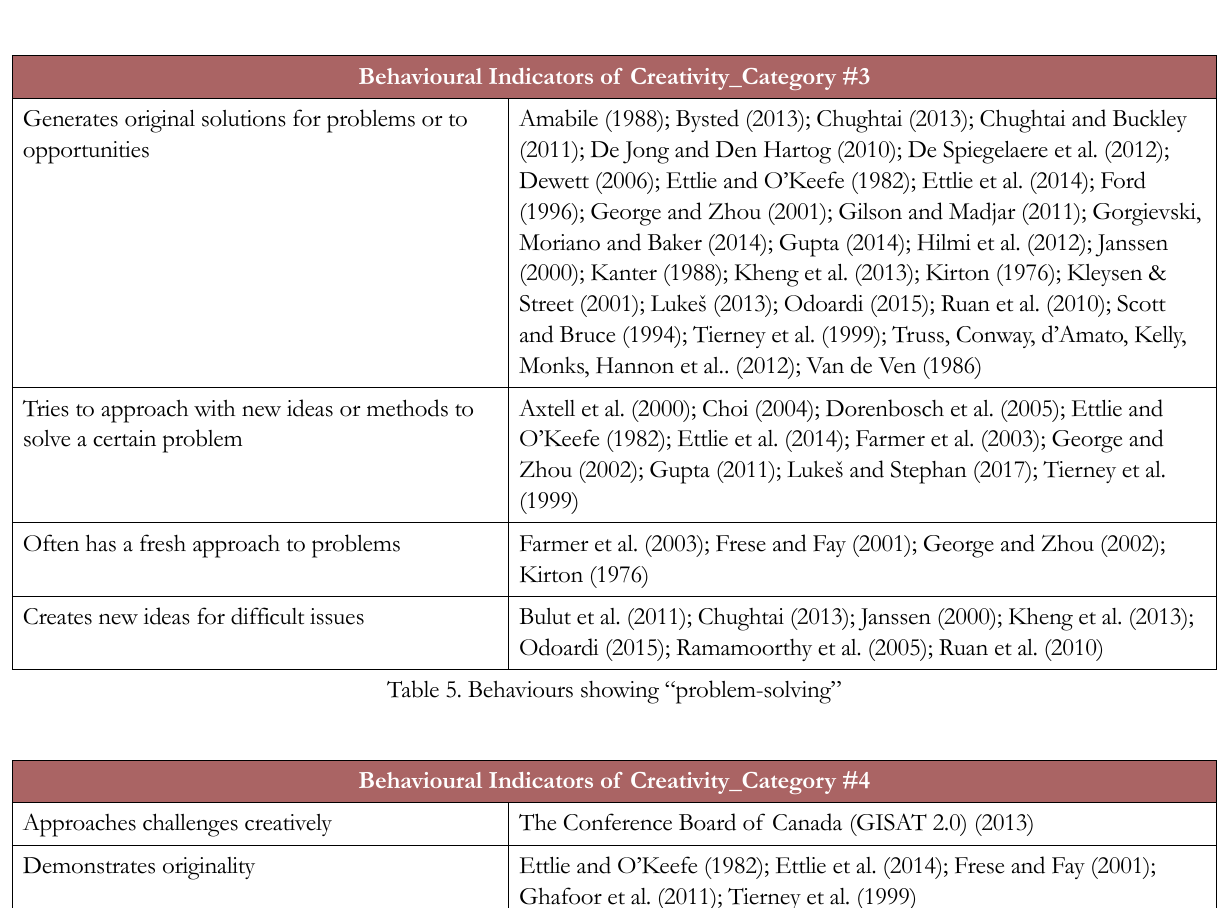
Table 4. Behaviours showing “improvement”